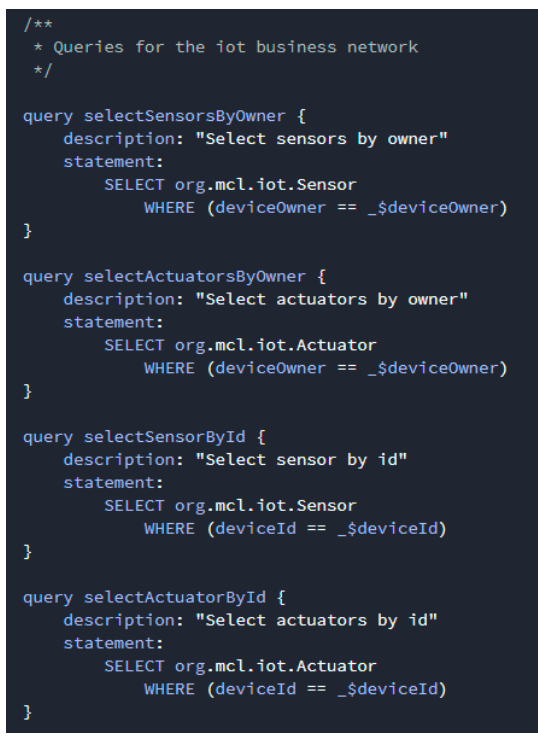
Figure 10 . Query definition in smart contract. Figure 10. Query definition in smart contract.